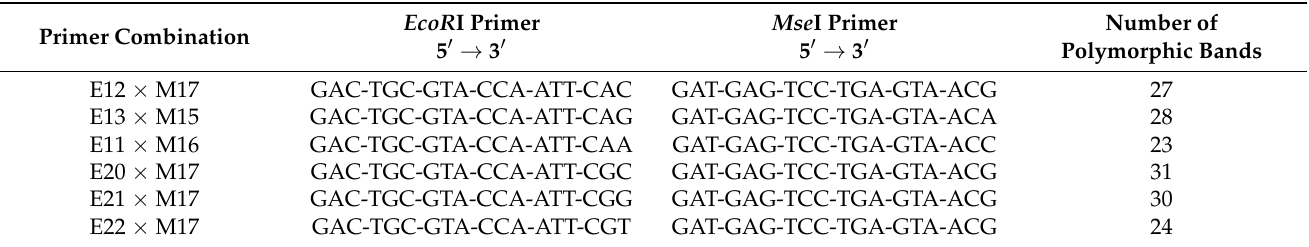
Table 2. Nucleotide sequences of the selective primers used for AFLP analyses and the number of polymorphic bands resulting from each primer combination. EcoR I Primer Primer Combination